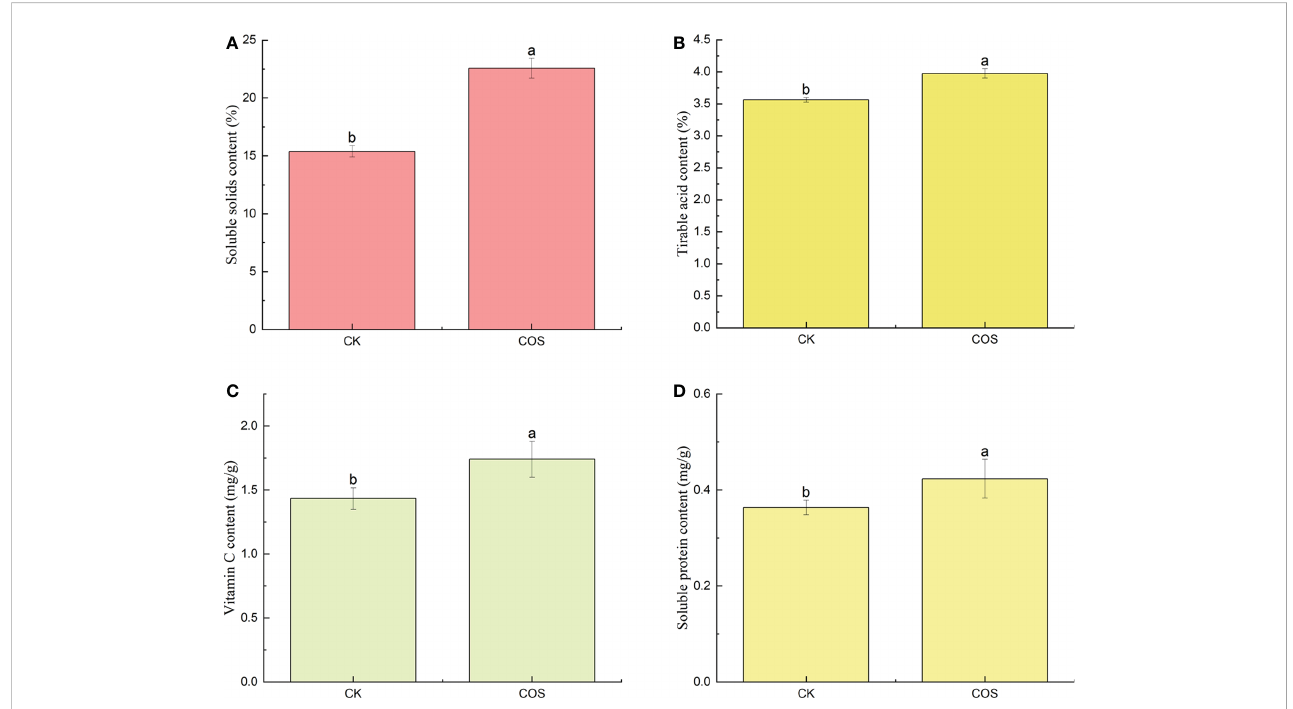
FIGURE 1 Effect of COS on the soluble solids (A) , titratable acids (B) , vitamin C (C) , and soluble proteins (D) contents of Passi fl ora spp. fruits. Different lowercase letters indicated the effect of COS on the soluble solids, titratable acids, vitamin C, and soluble proteins contents of Passi fl ora spp. fruits with signi fi cant difference compared with CK group (p < 0.05).